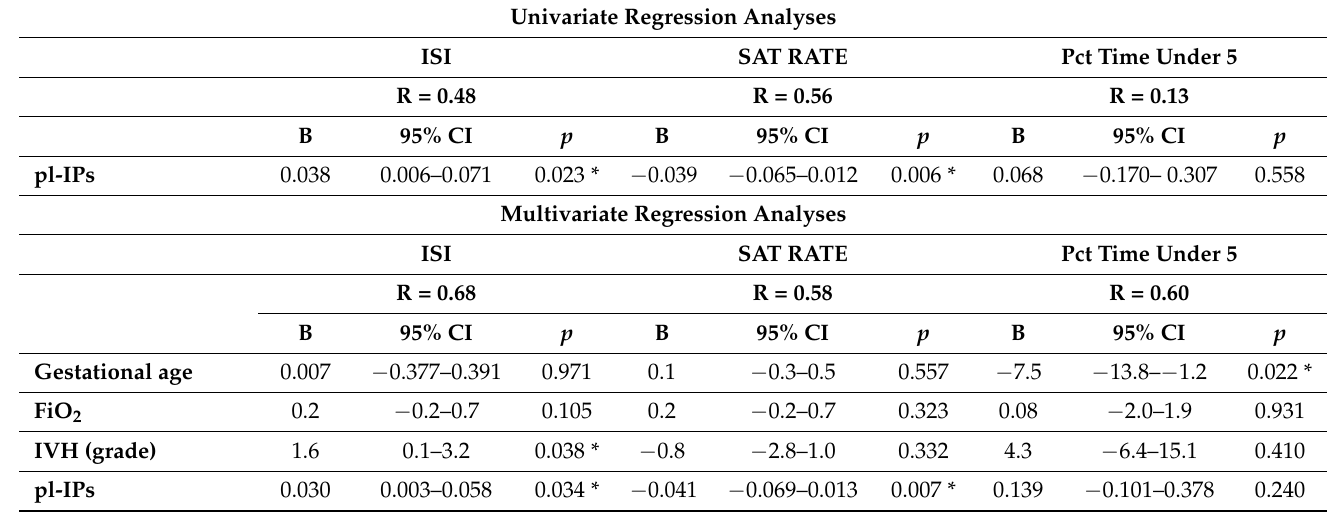
Table 3. Univariate and multivariate linear regression analysis: pl-IPs between 24 and 48 h after birth and early brain activity at day